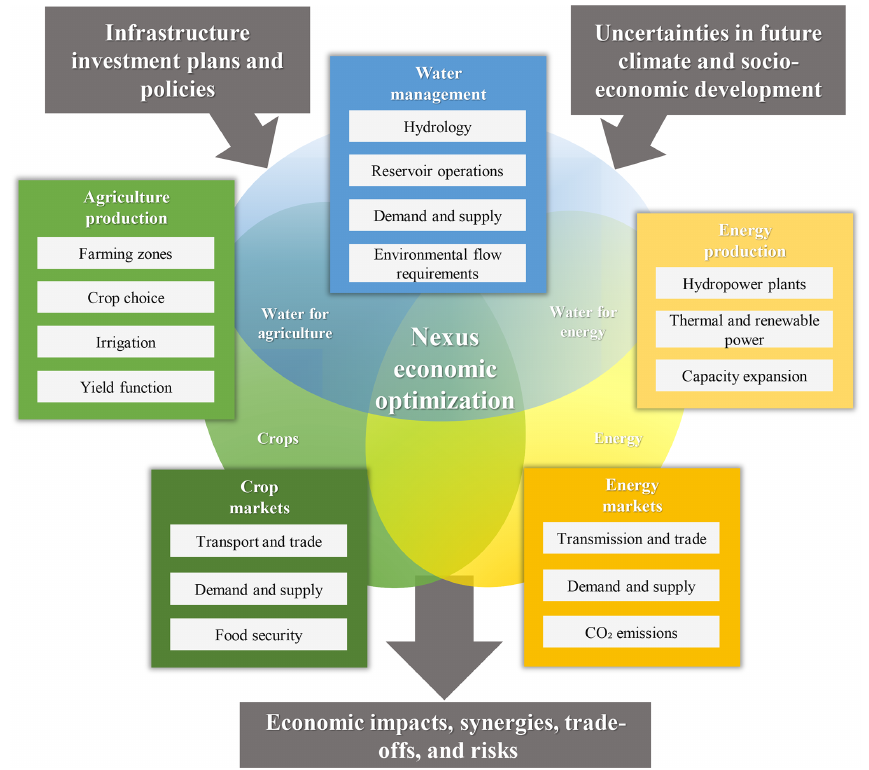
Figure 1. Conceptual framework of the decision support tool. The water, agriculture, and energy system are connected in the economic optimization framework. The blocks represent the different processes used in the model to represent the water, energy, and food systems, while the circle contains the economic and physical interactions. The block representation is for explanatory purposes only; interactions are solved using a holistic